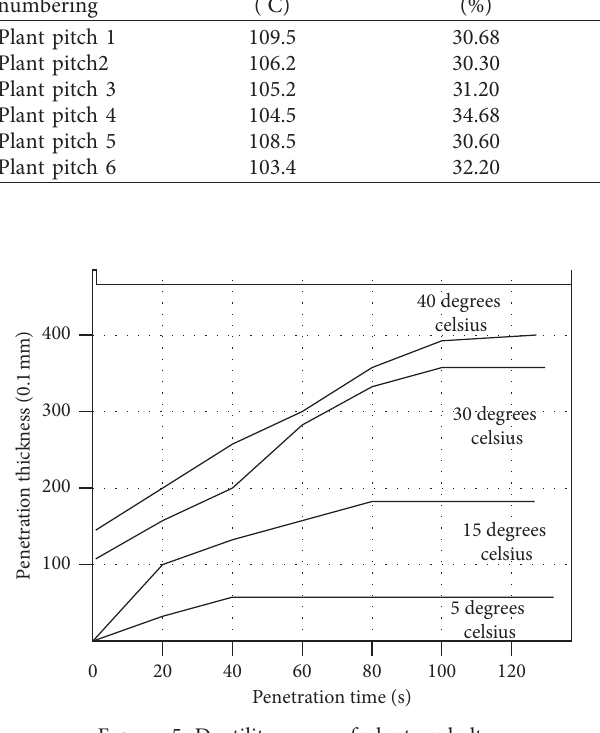
Figure 5: Ductility curve of plant